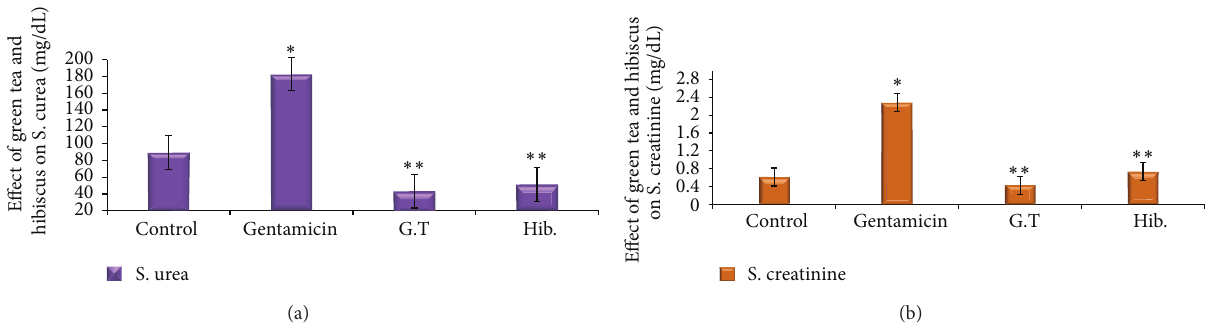
Figure 1: (a) Effect of green tea (300mg/d) and hibiscus (250 mg/d) on the (mean ± SE) nonenzymatic markers of kidney dysfunction (serum urea mg/dL) for 7 days in adult rabbits ( 𝑛 = 6 ). ∗ Significant as compared with control at 𝑃 value < 0.05. ∗∗ Significant as compared with gentamicin-induced nephrotoxicity at 𝑃 value < 0.05. G.T: green tea, Hib: hibiscus. (b) Effect of green tea (300mg/d) and hibiscus (250 mg/d) on the (mean ± SE) nonenzymatic markers of kidney dysfunction (serum creatinine mg/dL) for 7 days in adult rabbits ( 𝑛 = 6 ). ∗ Significant as compared with control at 𝑃 value < 0.05. ∗∗ Significant as compared with gentamicin-induced nephrotoxicity at 𝑃 value < 0.05. G.T: green tea, Hib: hibiscus.